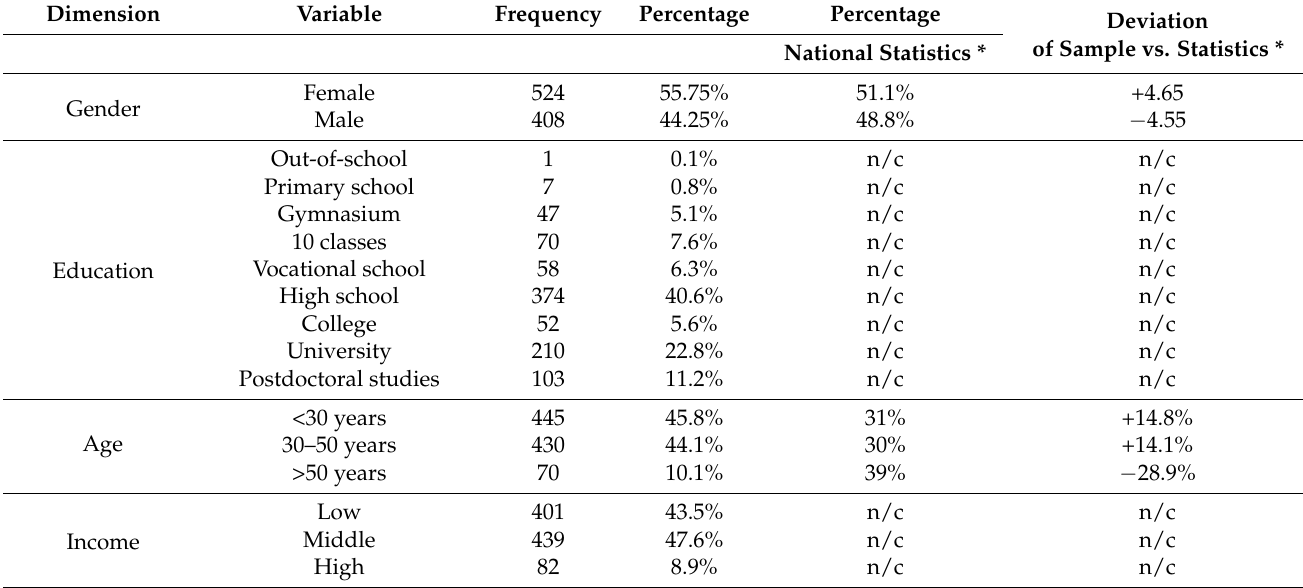
Table 1. Socio-demographic characteristics of the sample versus Romanian